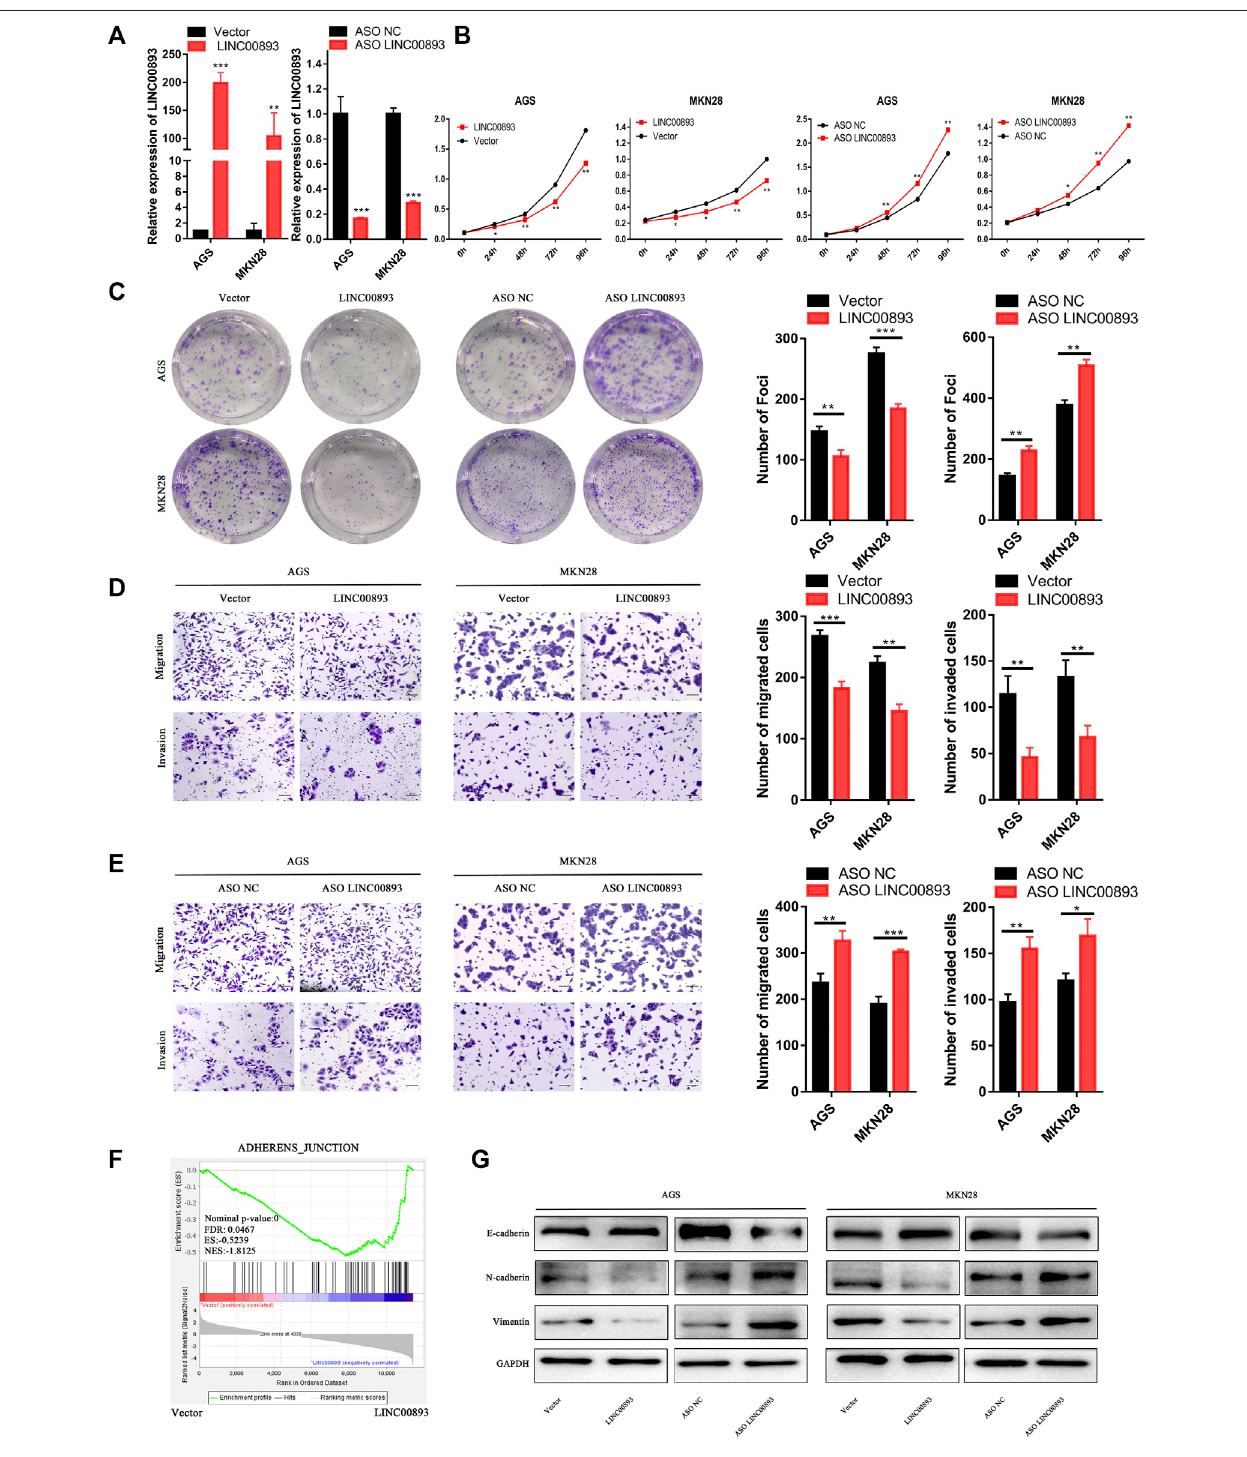
FIGURE3| LINC00893inhibitsGCcellproliferation,migration,invasionandEMT invitro (A) LINC00893wasoverexpressedorknockeddowninAGSandMKN28 cells (B,C) The effects of LINC00893 overexpression or knockdown on proliferation and plate colony-forming ability were measured in GC cells (D,E) The effects of LINC00893 overexpression or knockdown on migration and invasion were detected in GC cells (F) RNA-seq and Gene Set Enrichment Analysis (GSEA) of AGS treated with vector or LINC00893 overexpressed plasmid (G) Relative expression of E-cadherin, N-cadherin and Vimentin in GC cells after LINC00893 were either overexpressed or knocked down. * p < 0.05, ** p < 0.01, *** p < 0.001.